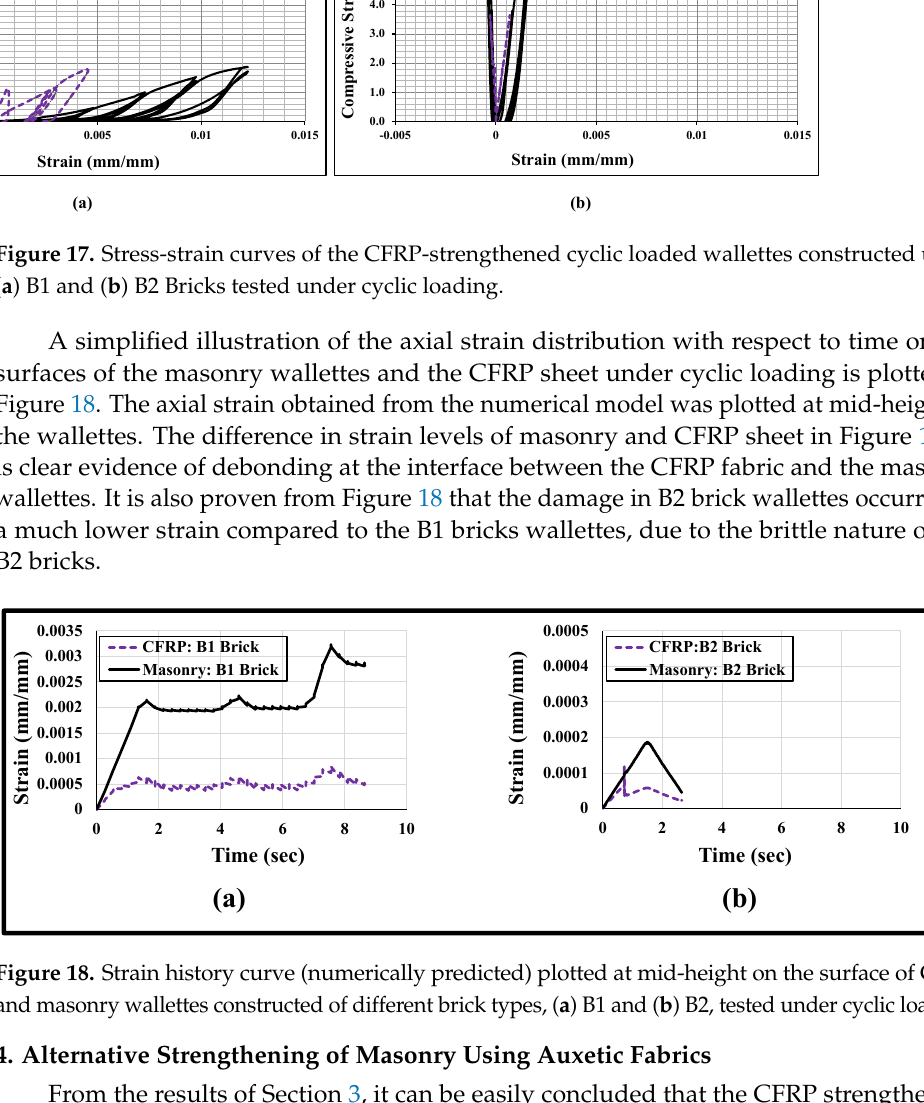
Figure 16. Numerically predicted damage on the surface of the CFRP fabric and masonry wallettes constructed of different brick types; ( a ) B1 and ( b ) B2 under cyclic loading.